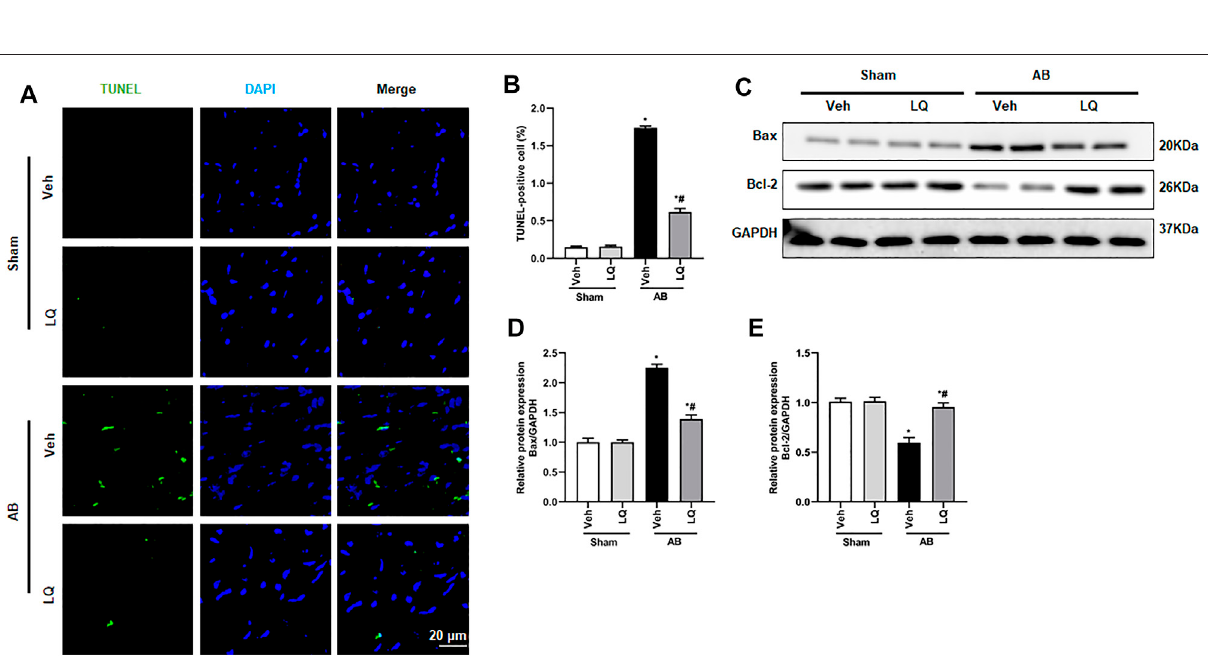
Frontiers in Pharmacology |